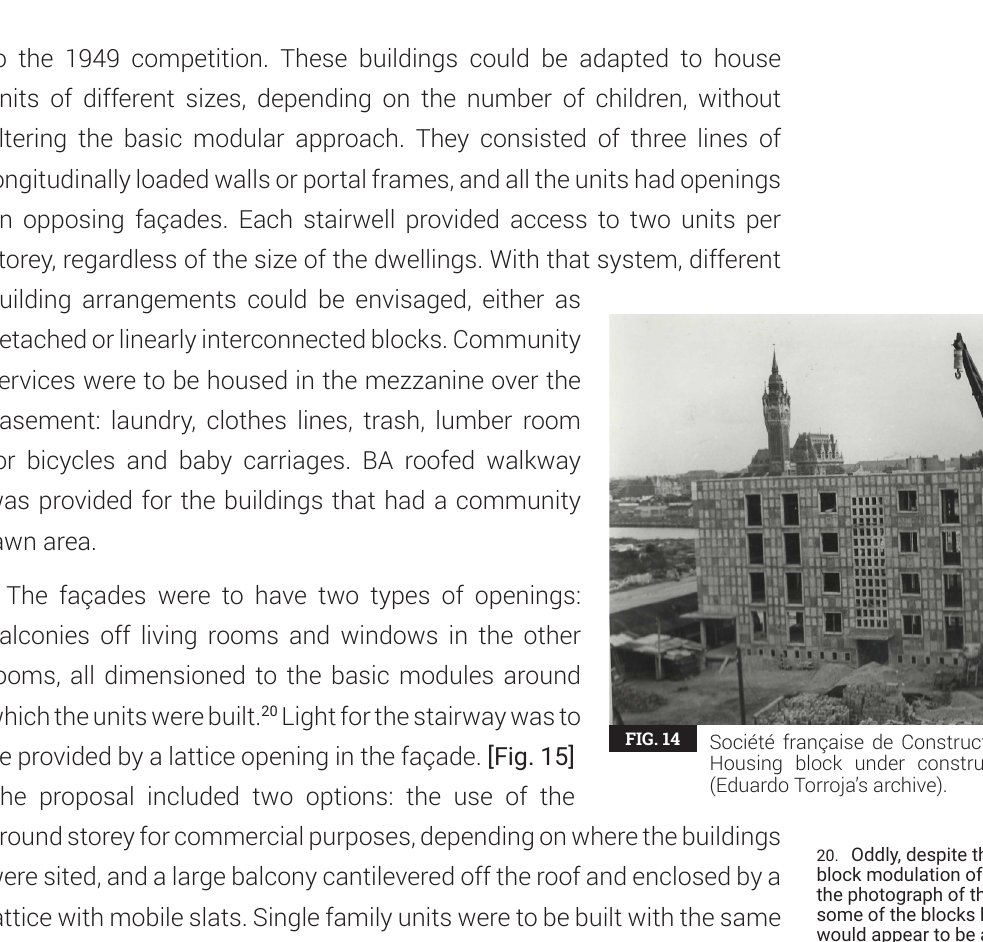
20. Oddly, despite the lightweight concrete block modulation of windows and balconies, the photograph of the façade shows that some of the blocks had to be sawn, for what would appear to be a mismatch between the indoor clearances and the